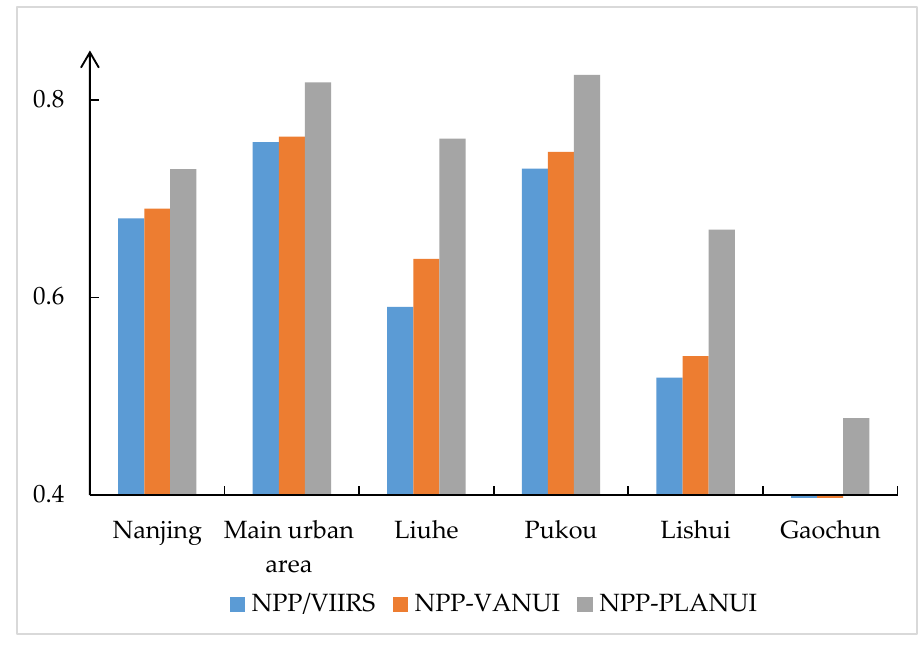
Figure 8. Comparison of Kappa coefficients of extraction results based on ( a ) Luojia 1-01 and ( b ) NPP/VIIRS in Nanjing and in the five selected regions: Main Urban Area, Liuhe, Pukou, Lishui, and Gaochun.